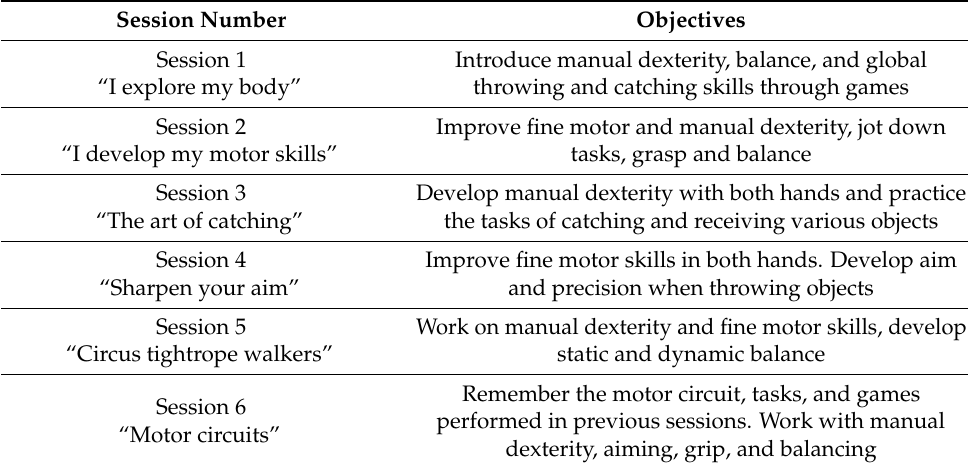
Table 1. Objectives and tasks performed in each of the 6